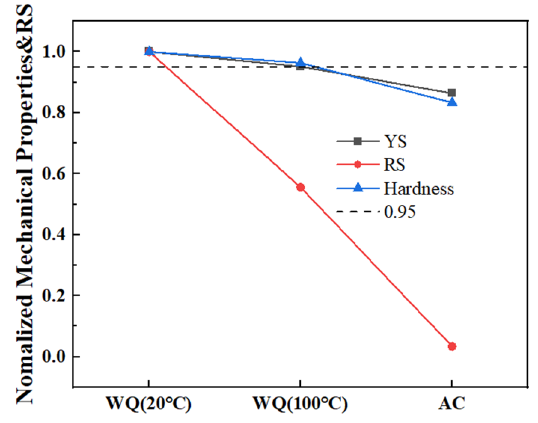
Figure 17. Normalized mechanical properties and RS.